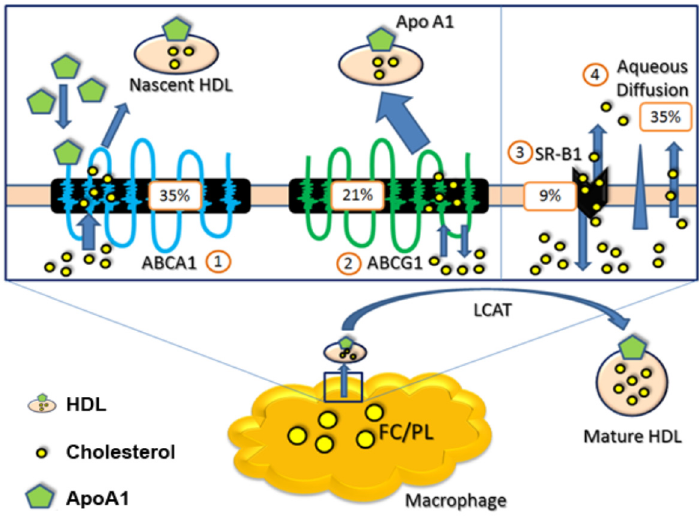
Figure 2. Macrophage cholesterol efflux routes and relative contributions to cholesterol efflux by percent [10]. Abbreviations: ABCA1 = ATP-binding cassette transporter A1, ABCG1 = ATP-binding